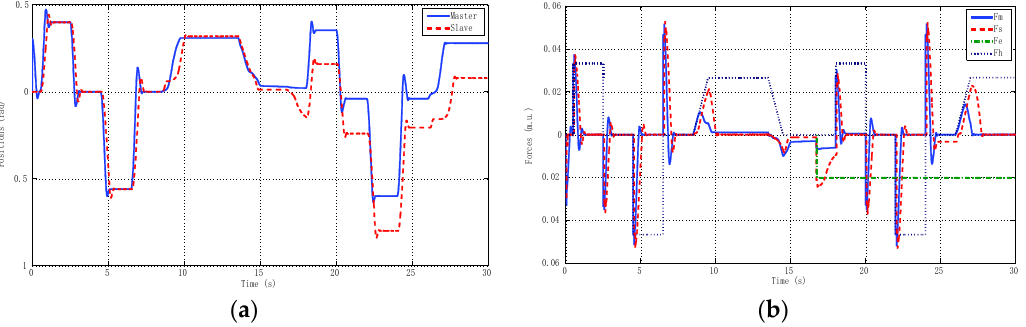
Figure 18. Real remote teleoperation between Vigo and Manchester using haptic devices. ( a ) Positions; ( b ) Forces.